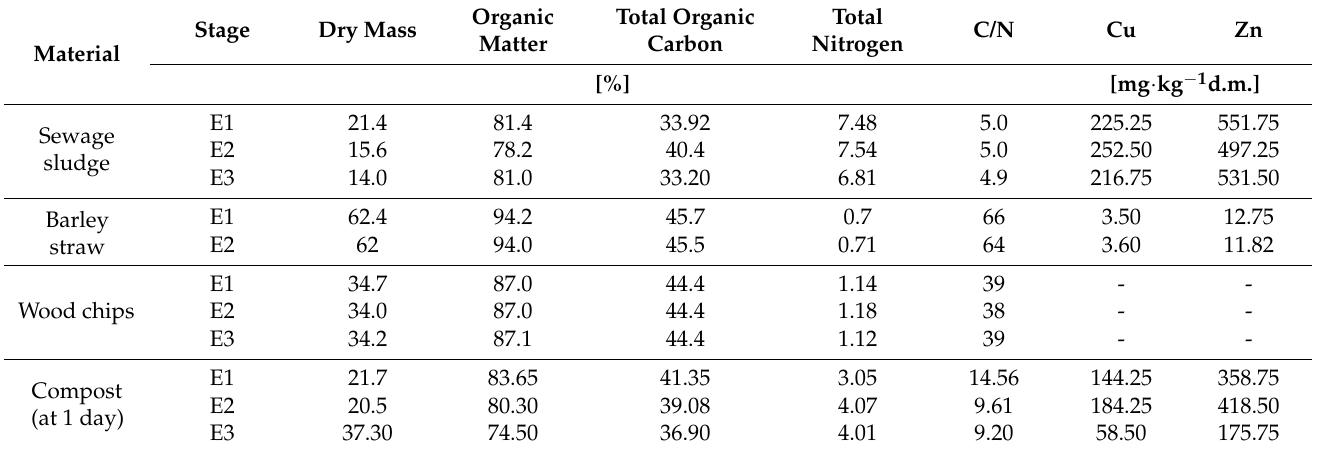
Table 3. Physical and chemical characteristics of the composting initial mixtures used.